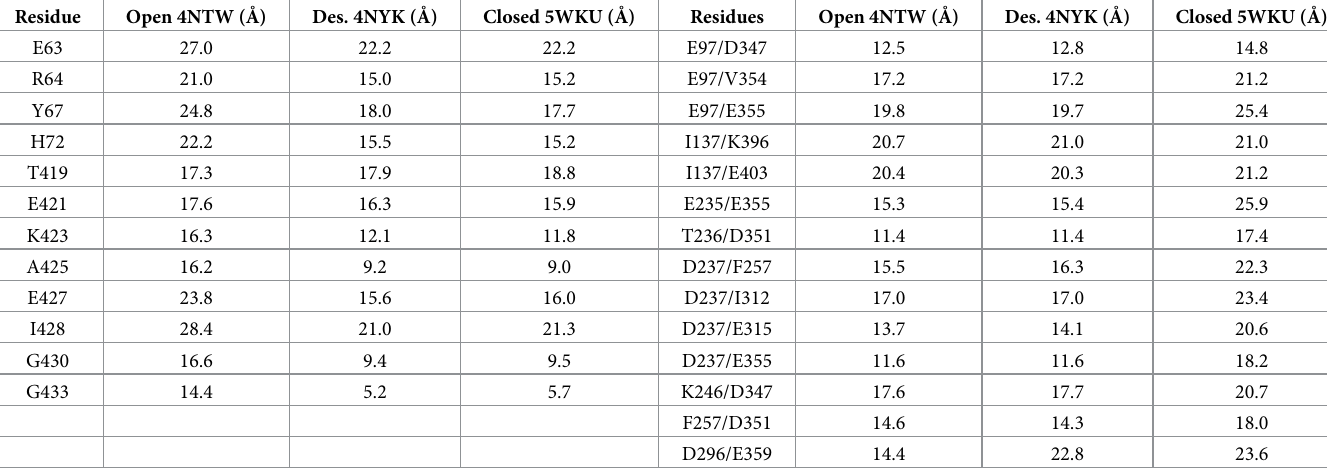
Distances between residues that were mutated to Cys in this study, determined between C β -atoms (Ca for Gly) of open (4NTW, [14]), desensitized (4NYK, [14, 15]) and closed state (5WKU, [18]) models of human ASIC1a. The indicated distances were measured in hASIC1a models between two subunits for single mutants and within a single subunit for double